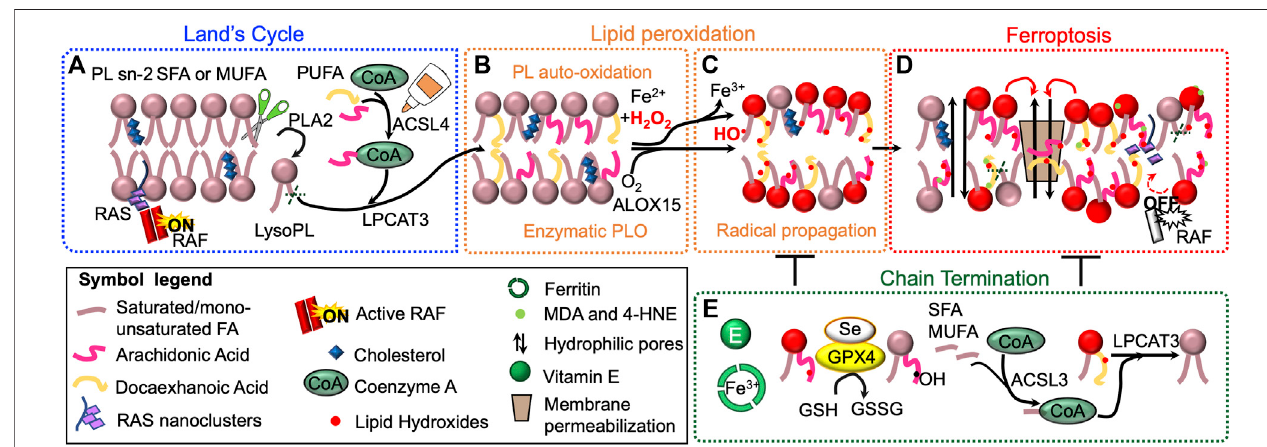
FIGURE 3 | Lipid peroxidation drives ferroptosis. Phospholipid (PL) acyl chain remodeling (Land ’ s cycle) is responsible for the enrichment of membranes with polyunsaturated fatty acids (PUFA), when monounsaturated (MUFA) and saturated (SFA) FA become limiting. Phospholipase A2 (PLA2) removes acyl chain at sn-2 position. Lysophosphatydilcholine-acyltransferase-3 (LPCAT3) re-esteri fi es the position using PUFA-CoA, generated by acyl-CoA long-chain family member 4 (ACSL4) (A) . Membranes PL enriched with PUFA are prone to undergo iron – dependent lipid peroxidation (LPO) possibly via Fenton chemistry or enzymatic oxygenation ( e.g .ALOX15) (B) .Onceproduced,lipidhydroxides(LOOH),ifnotclearedbythecellularantioxidantsystems,canpropagateLPOtootherPUFA-containingPL (C) .LPO can lead to ferroptotic cell death (highlighted in red) through several mechanisms (D) . First, LOOH can alter membrane properties, which could allow the formation of hydrophilic pores and induce membrane permeabilization (i). Second, lipophilic electrophiles formed during the lipid peroxidation event could affect membrane-bound proteins and their signaling cascade (ii). LOOH can also generate second, more stable and highly reactive LPO products, as malondialdehyde (MDA), and 4-hydroxy-2- nonenal (4-HNE) (iii). Finally, LPO can alter lipidomic signature and affect cancer cell metabolism (iv). Cellular antioxidant systems and phospholipid remodeling can counteract and terminate LPO (E)